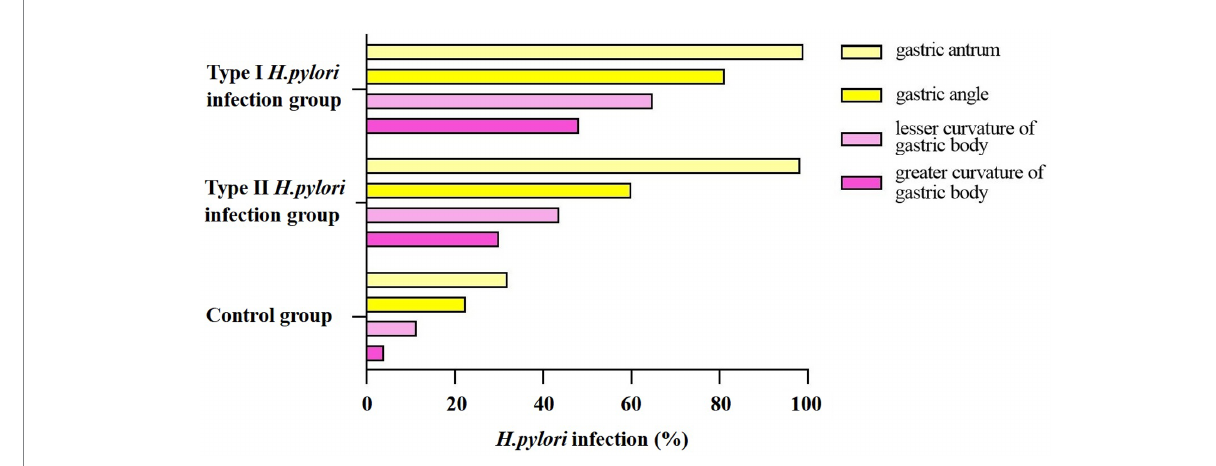
FIGURE 3 Distribution of different types of Helicobacter pylori infection in different parts of the stomach.